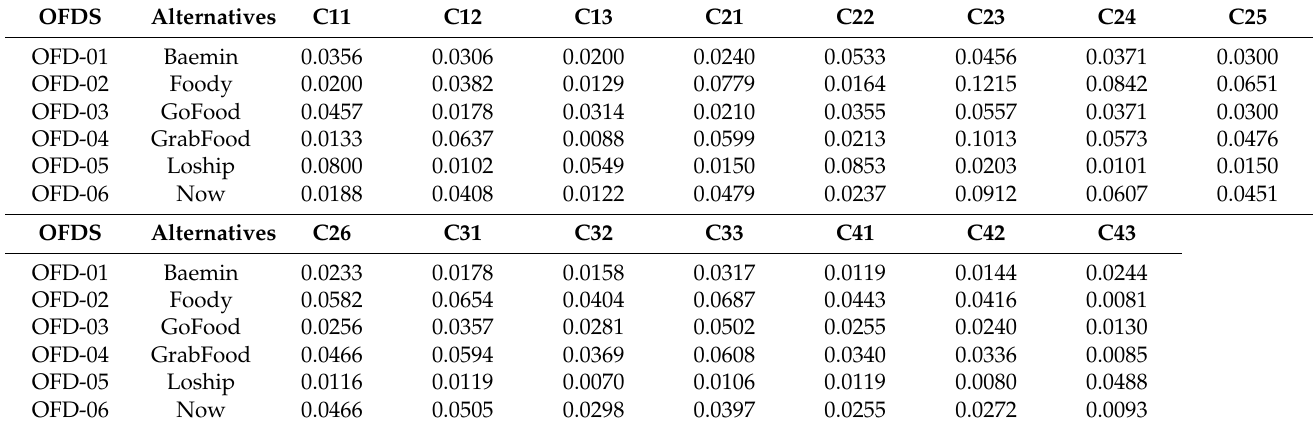
Table 9. The weighted normalized matrix for WSM (WASPAS model).